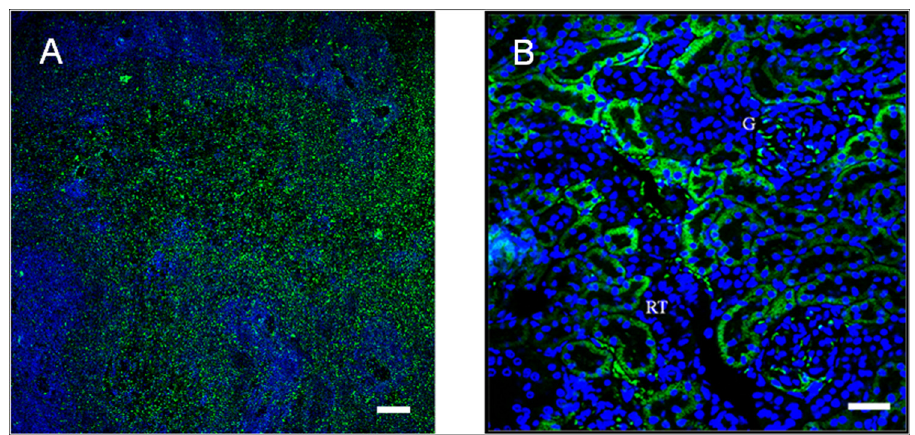
Fig 5. Detailed view of immunolabeling of CB 2 in the spleen and the kidney. Detailed view of CB 2 immunolabeling in the spleen (A), used as a positive control of the primary antibody (Scale bar = 100 μ m). Detailed view of CB 2 immunolabeling of epithelial cells of the renal tubules (RT) and the glomerule (G) of the kidney (B). (Scale bar = 30 μ m).